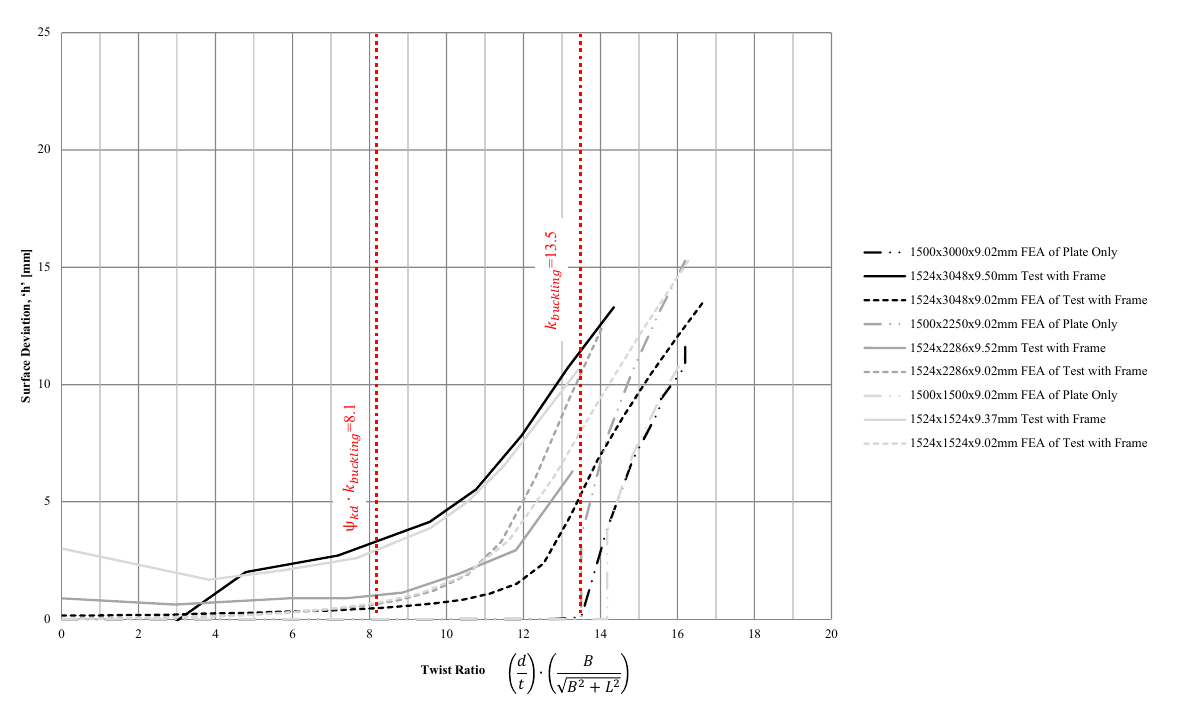
Fig. 11 Buckling Comparison to Previous Finite Element Analysis and Physical Tests at